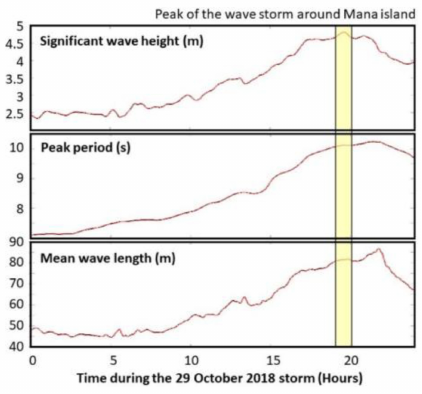
Figure 10. Time evolution of the AdriSC unSWAN 1-min results of significant wave height, peak period and mean wave length on 29 October 2018 in the vicinity of Mana Island at 42 m